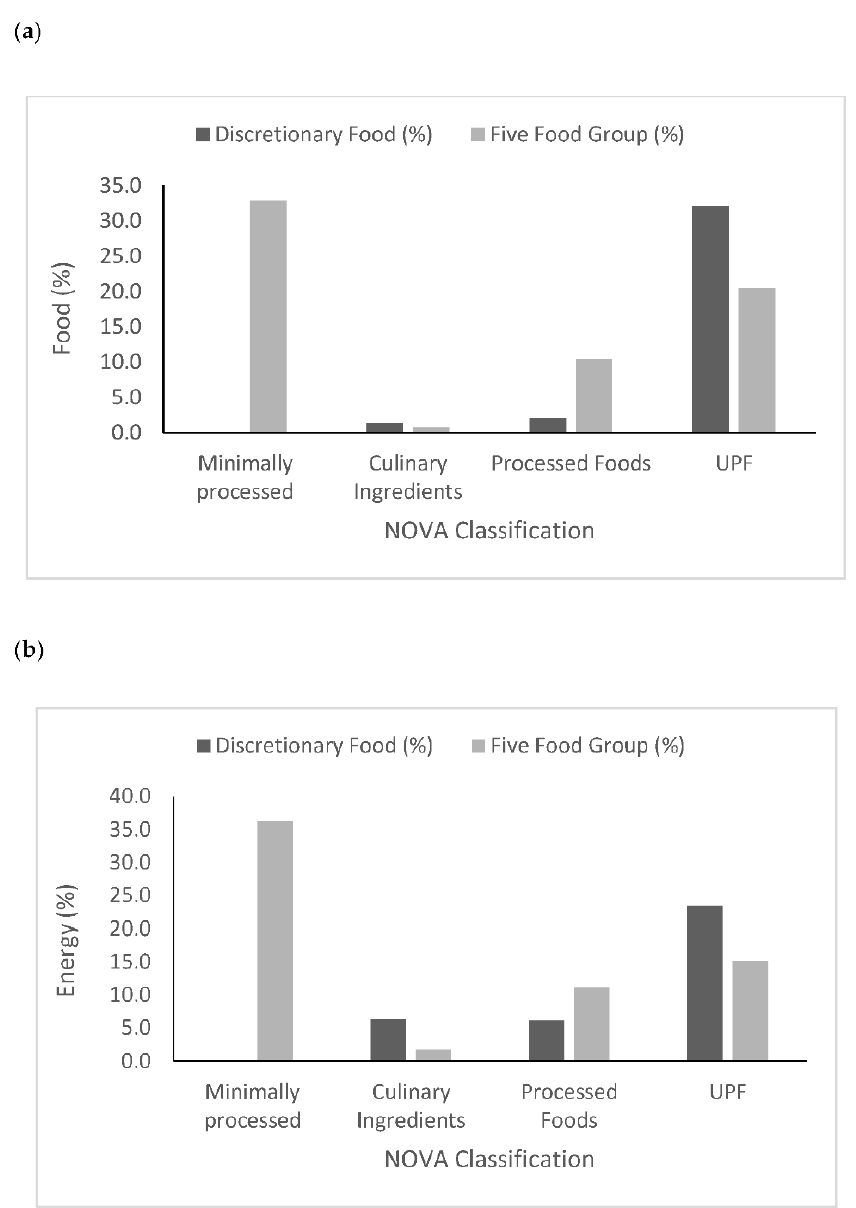
Figure 1. ( a ) T otal number of foods reported in the survey ( n = 2486); ( b ) proportion of daily